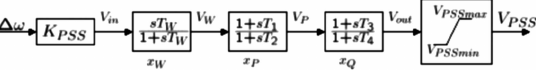
Fig. A.1. Representation of the used PSS